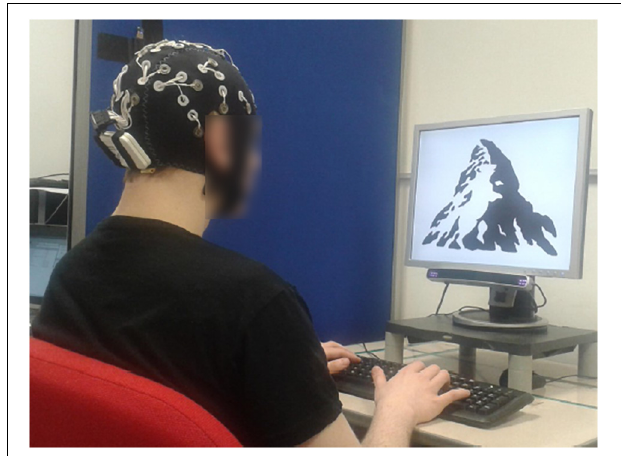
FIGURE 2 | Experimental setup and exemplar of a bistable stimulus (mountain/bear) displayed on the monitor while the participant was performing the ambiguous perceptual task. The participant signed a consent for publication of this